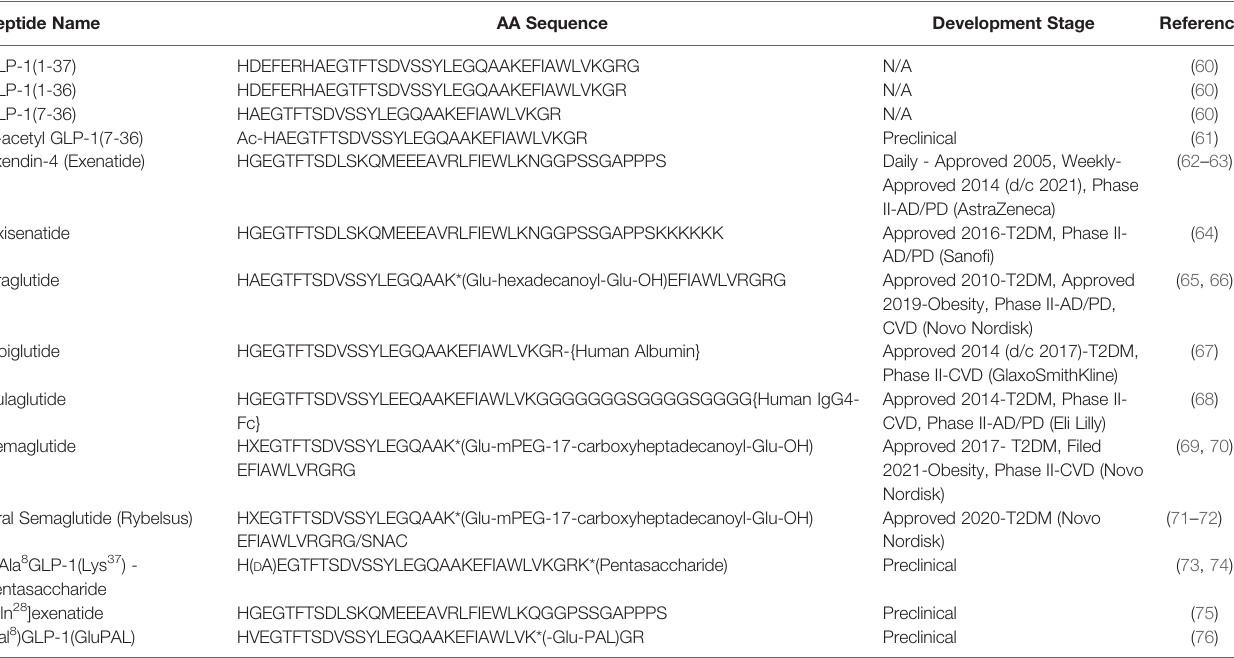
TABLE 2 | GLP-1-based therapeutic